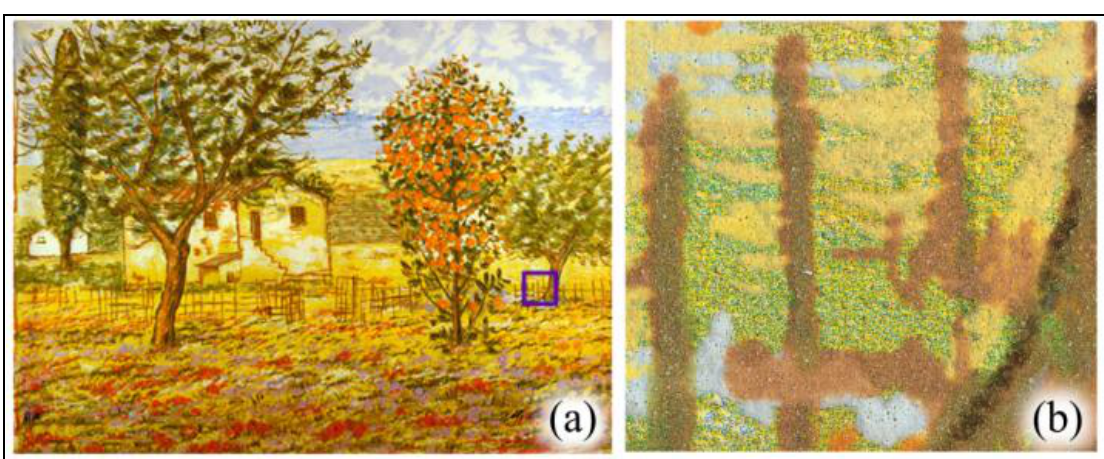
Figure 9. Cascella’s Albero di Arancio lithograph. ( a ) Lithograph with the zone used for certification highlighted. ( b ) Portion of the lithography acquired by a smartphone ( I